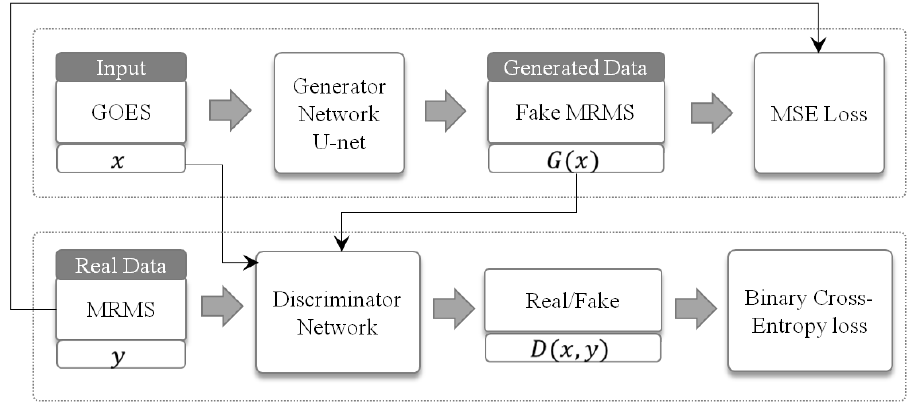
Figure 3. Schematic conditional Generative Adversarial Network